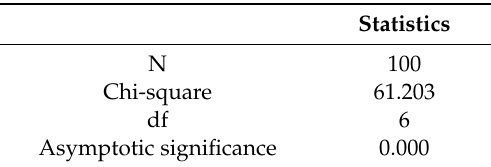
Table 30. Friedman’s test—for each factor of